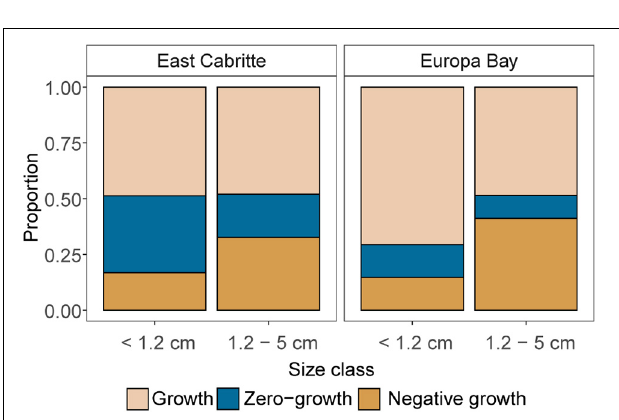
FIGURE 10 | Proportions of events in which growth, zero-growth and negative growth were observed for colonial recruits smaller and larger than median recruit height (1.1 cm) at each study site. Negative growth, i.e., partial mortality, occurred more often to larger recruits ( > 1.2 cm tall), independently of site, whereas we observed no-growth more frequently on smaller recruits at East